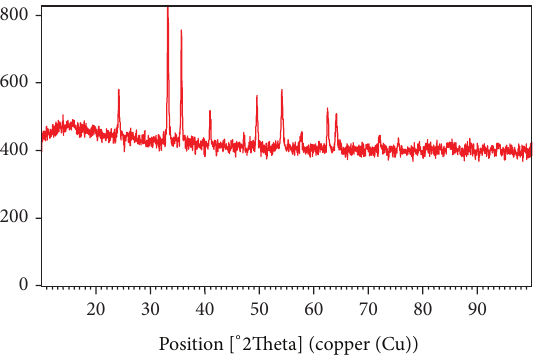
Figure 1: -XRD spectra of synthesized iron